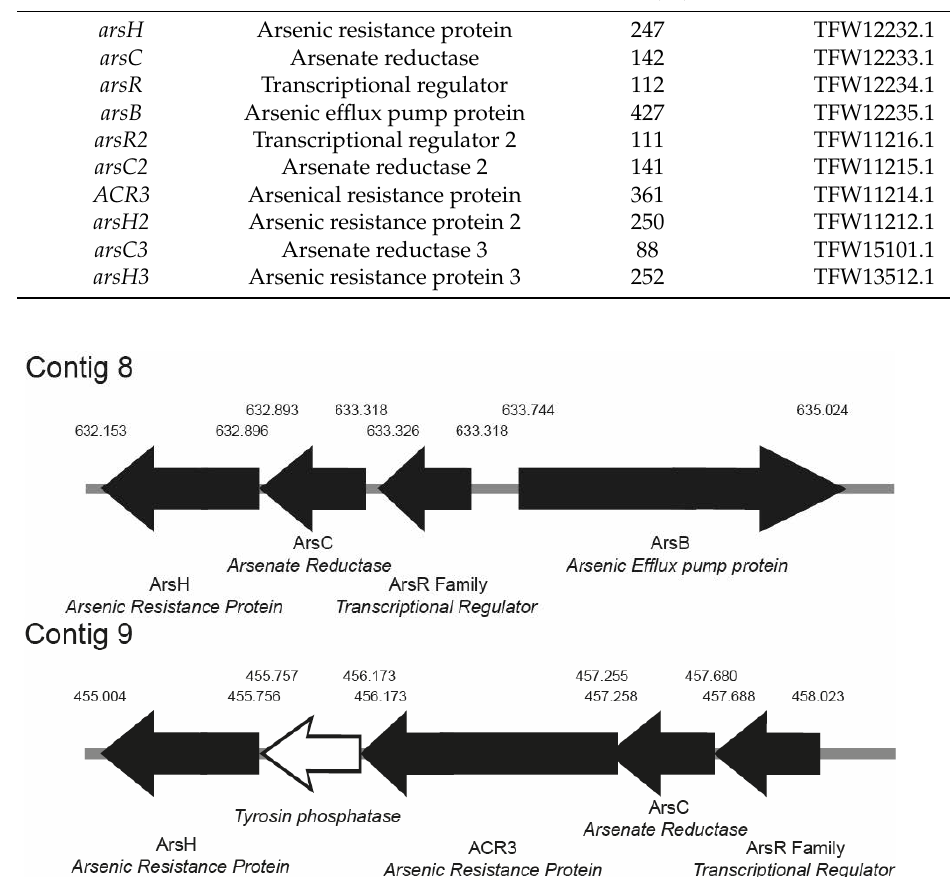
Figure 3. Genetic organization of the two arsenic resistance operon in strain Brevundimonas sp. B10. Gene orientations are shown by arrows.